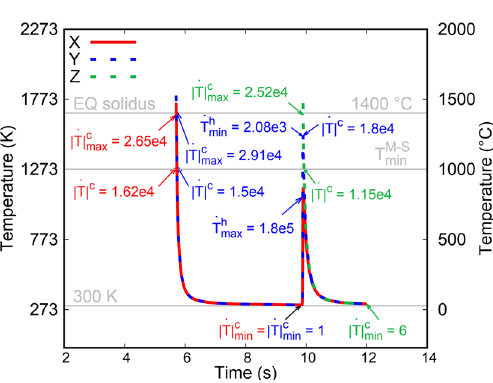
Figure 7. Temperature v/s time curves obtained from the heat transfer FE simulation of LMD of the 3-layer wall of Fig. 1b at the locations X, Y and Z. The temperature rates shown inside the plot have units K/s. Superscript ‘c’ implies cooling and ‘h’ implies heating. The rates in red, blue and green font correspond to the rates encountered by points X, Y and Z, respectively, during LMD. The subscripts ‘min’ and ‘max’ to the temperature rates correspond to minimum and maximum, respectively, rates for a given curve. EQ solidus M − S stands for the equilibrium solidus temperature. T min is the minimum temperature below which M–S (M = Mn, Cr and Fe) does not precipitate for any temperature rate in the range 1–10 7 K/s (see discussion related to Figs. 9 and 10). While the simulation begins at 0 s, however, X and Y are deposited at 5.7 s and Z is deposited at 9.9 s after the start. Gnuplot v5.4 (http:// www. gnupl ot. info) was used to prepare this